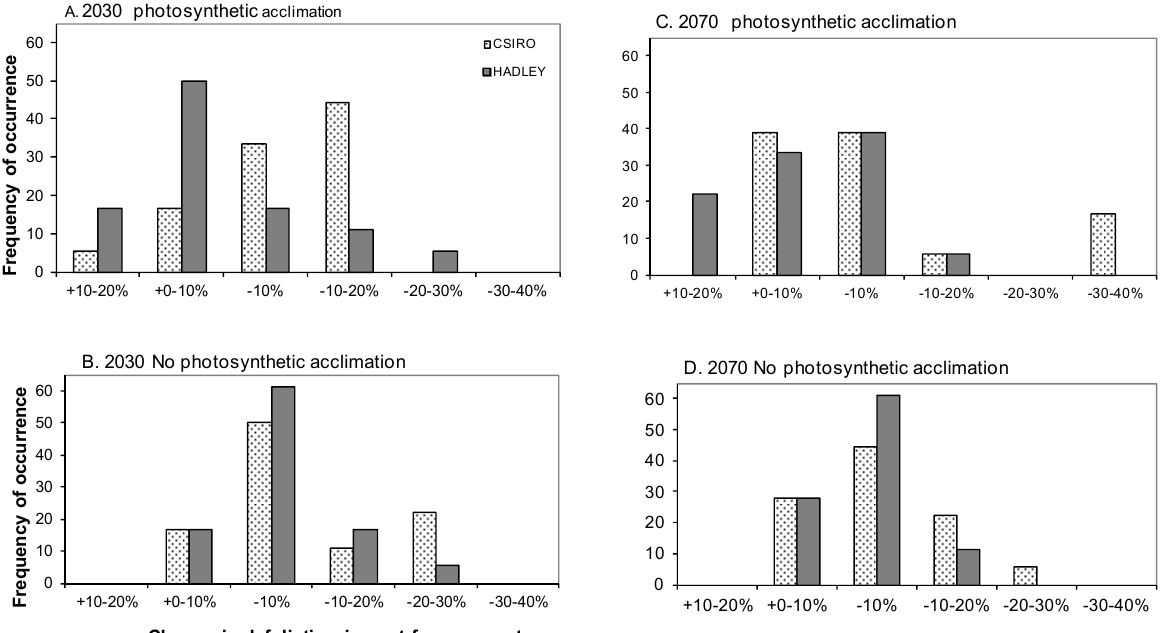
Figure 3. Changes in defoliation impact for E. globulus , compared to predictions under current climate, for ( A ) 2030 climate and photosynthetic acclimation; ( B ) 2030 climate and no photosynthetic acclimation; ( C ) 2070 climate and photosynthetic acclimation; and ( D ) 2070 and no photosynthetic acclimation. The frequency of occurrence is shown for both the CSIRO and Hadley GCMs. A positive value on the x -axis indicates a reduction in defoliation impact compared to current; a negative value indicates an increase in defoliation impact compared to impact predicted for current